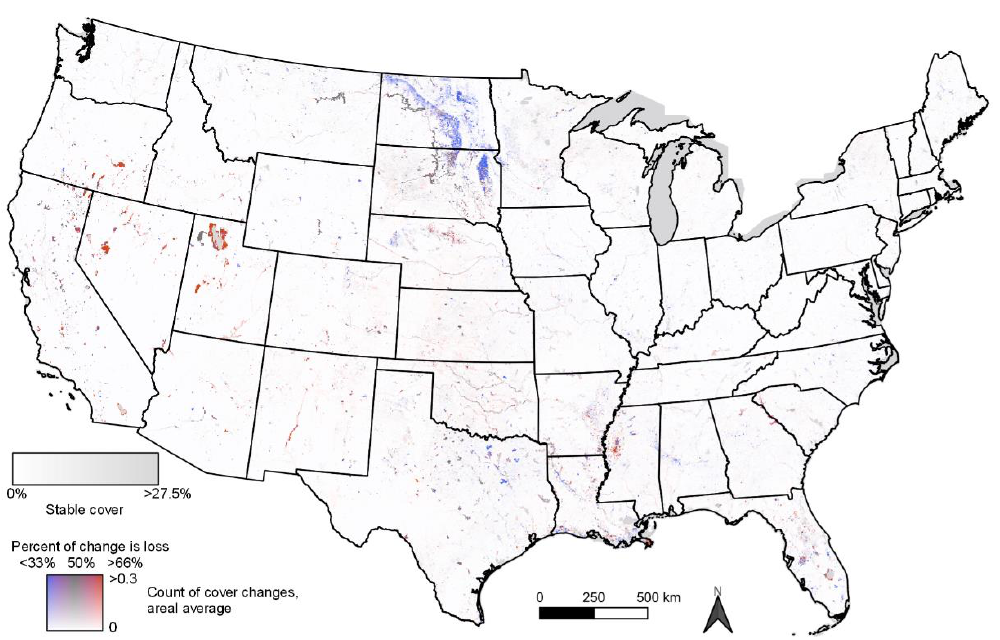
Figure 9. Water dynamics during 1985 – 2016. Gray shading shows areas where stable land cover of a specific class is present. Change information is shown by a two-dimensional color scale indicating both the amount and direction of change (blue for gain, red for loss; darker shades for more change). Figure values are derived from a 3 × 3 km (100 × 100 Landsat pixel) binning of the class change map product (LCACHG, see Section 2).